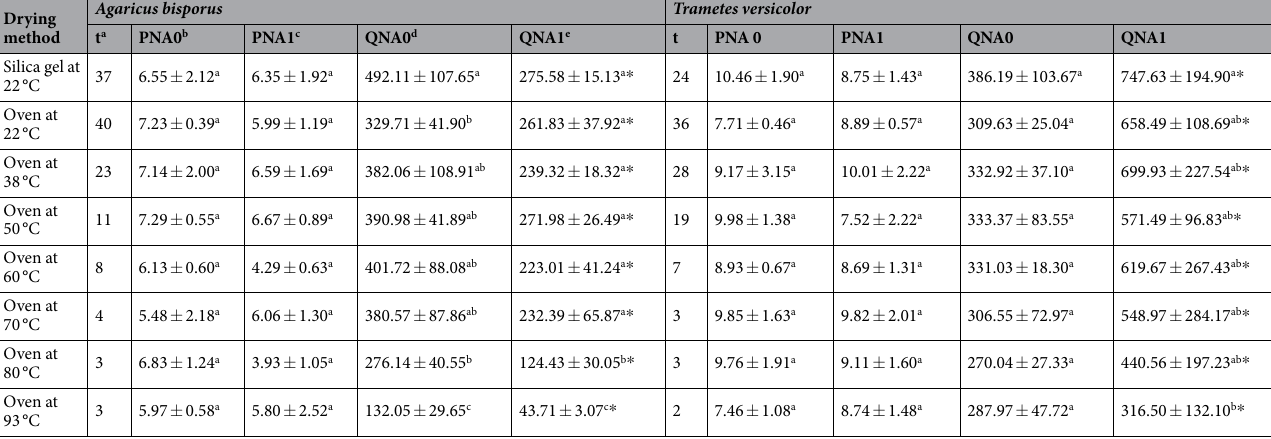
Table 4. Number of hours of drying required to reach a stable sample weight; the percentage of nucleic acids that are double-stranded DNA (dsDNA %); and the quantity of dsDNA (ng/mg of dried mushroom tissues) extracted from mushrooms dried using different methods. The means in each column followed by the same superscripts are not significantly different and the “ * ” marks in each row within the same specimen indicate significant differences between the two time points of DNA extractions at P < 0.05 according to Duncan’s multiple range tests. a t, Number of hours of drying by eight treatments to reach a stable sample weight. b PNA0, percentage of nucleic acids that are double-stranded DNA (dsDNA %) extracted immediately after drying. c PNA1, percentage of nucleic acids that are double-stranded DNA (dsDNA %) extracted after one-month storage after drying. d QNA0, quantity of dsDNA (ng/mg of dried mushroom tissues) extracted immediately after drying. e QNA1, quantity of dsDNA (ng/mg of dried mushroom tissues) extracted after one-month storage after drying.